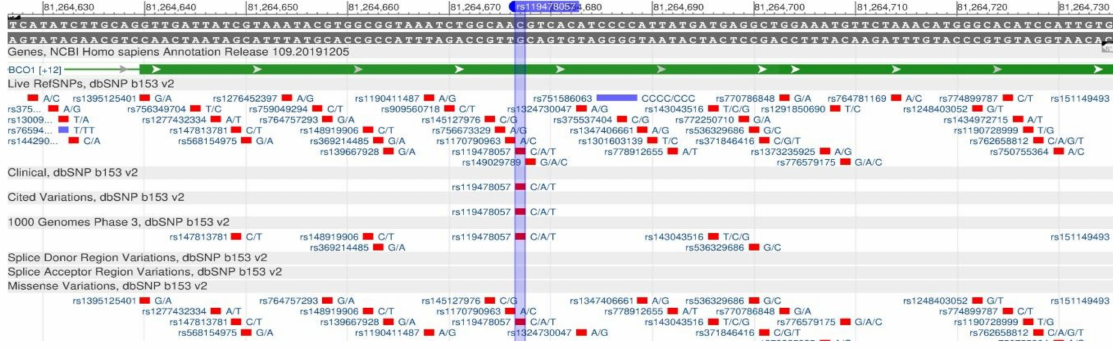
Figure 17. The BCMO1 gene region (located on the long (q) arm of chromosome 16) containing the oligonucleotide polymorphism rs119478057.